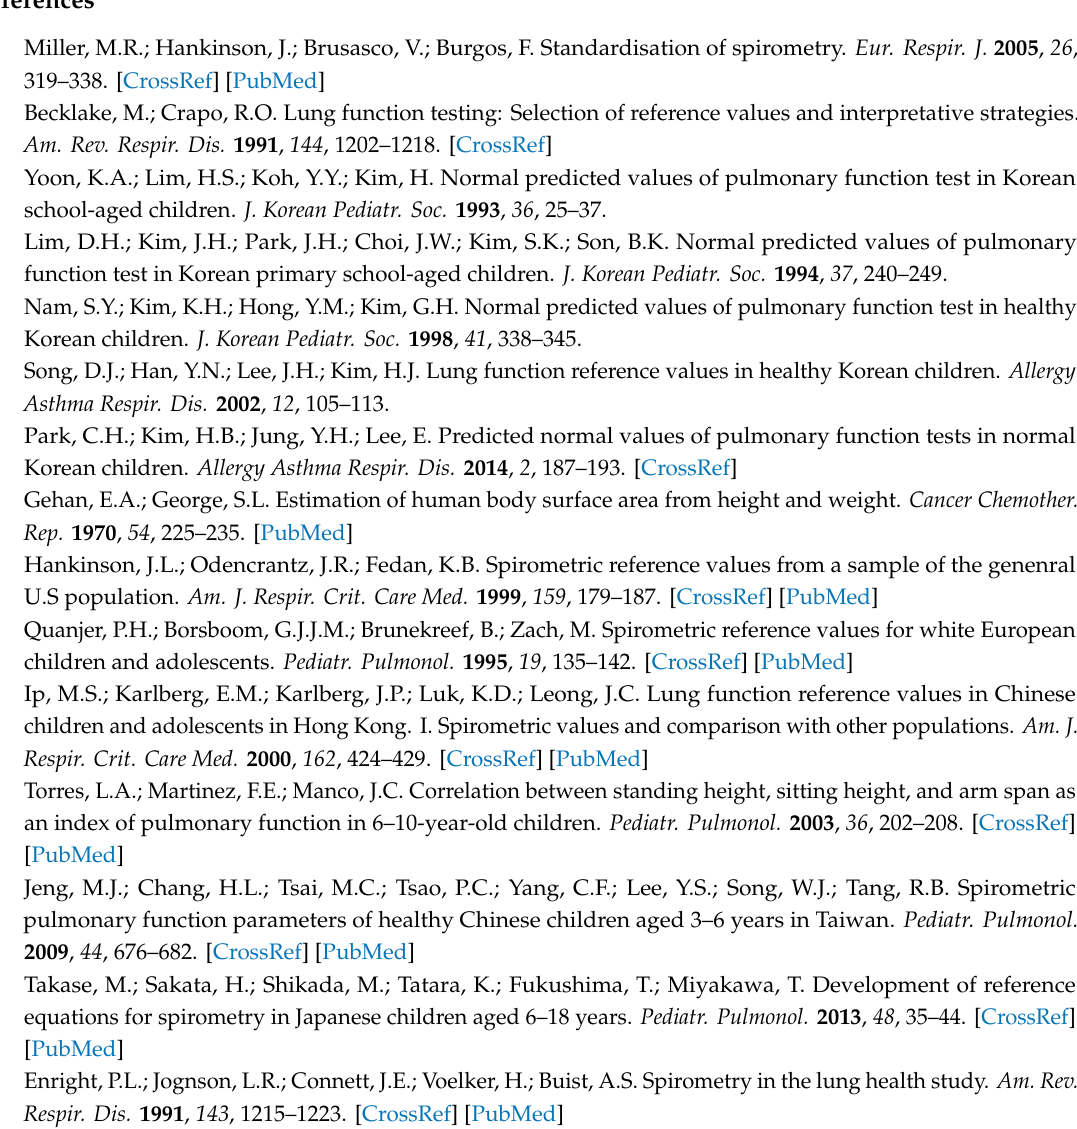
Figure S1: Relationship of ln FEV 1 to height, Figure S2: Relationship of ln FVC to height, Figure S3: Relationship of ln MMEF to height, Figure S4: Relationship of ln PEFR to height, Figure S5: Comparison of the FEV 1 according to height in males and females, Figure S6: Comparison of the FVC according to height in males and females, Figure S7: Comparison of the FEV 1 according to height in males and females, Figure S8: Comparison of the FVC according to height in males and females, Table S1: Physical characteristics of subjects by